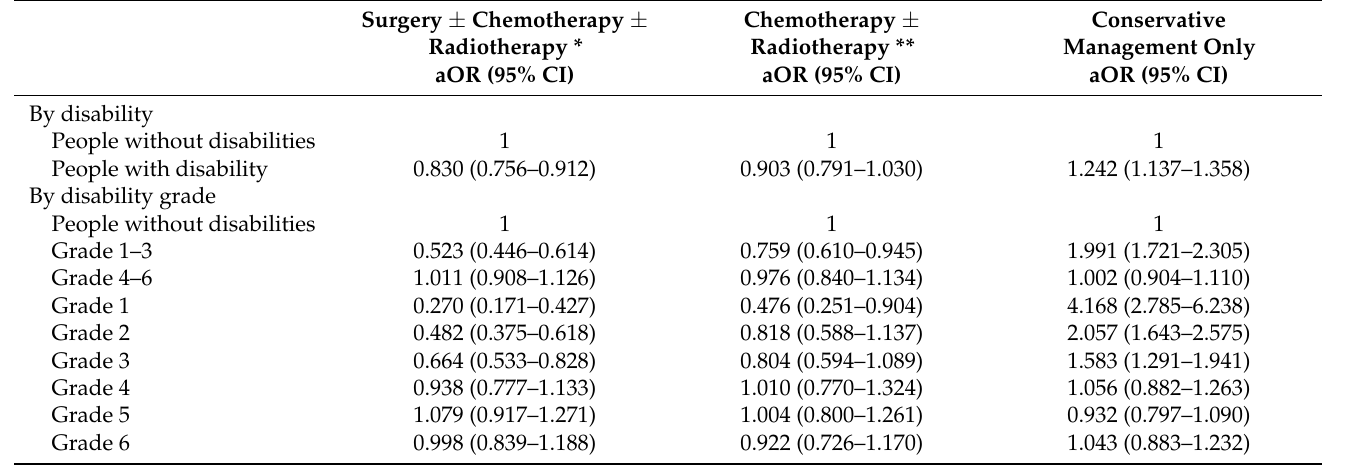
Table 4. Factors influencing level of surgery, chemotherapy or conservative management in